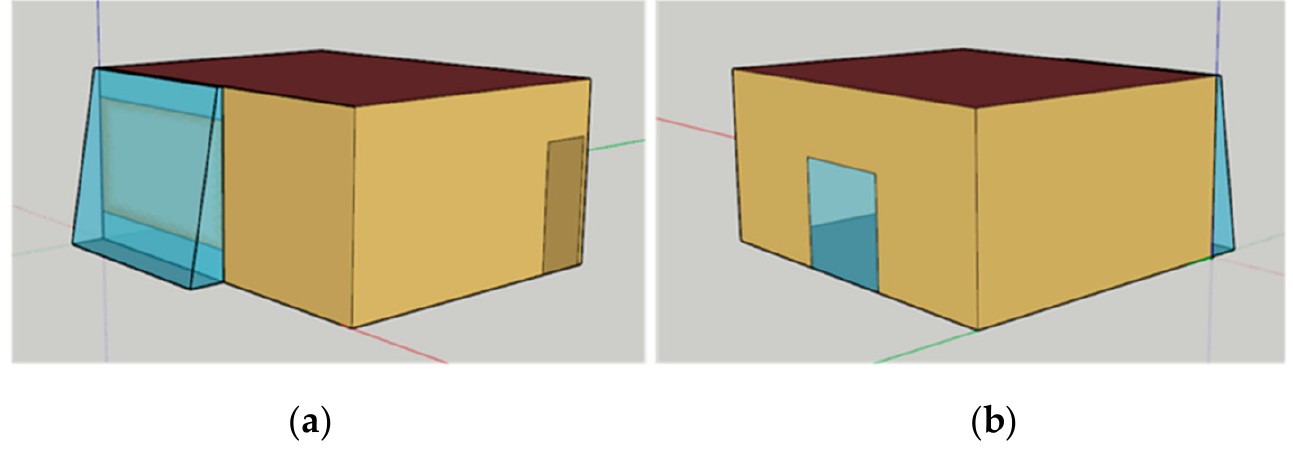
Figure 5. SketchUp map of the building model. ( a ) South side of the room; ( b ) North side of the room. Table 2. Physical parameters of room structure [38,39].